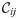
Cell assemblies and connectivity.a) Cross-correlation matrix C(νi, νj) of the firing rates organized according to the clusters generated via the k-means algorithm with k = 15, the clusters are ordered as in Fig 1(c) from the highest to the lowest correlated one. b) Connectivity matrix Cij with the indices ordered as in panel a). Here, a black (copper) dot denotes a 1 (0) in Cij, i.e. the presence(absence) of a synaptic connection from j to i. c) Average cross-correlation 〈C〉ml among the elements of the matrix block (m, l), versus the probability pml to have synaptic connections from neurons in the cluster l to neurons in the cluster m. d) 〈C〉ml versus the block averaged similarity metrics eml. Black squares indicate the blocks along the diagonal delimited by black borders in panel a) and b); blue triangles denote the ten blocks with the lowest 〈C〉ml values, which are also delimited by blue edges in a) and b). The vertical red dashed line in panel c) denotes the average probability to have a connection p = 5% and in panel d) the value of the metrics eml averaged over all the blocks. The black solid line in panel c) is the linear regression to the data (〈C〉ml ≈ 0.15–3.02pml, correlation coefficient R = −0.72). Other parameters as in Fig 1.